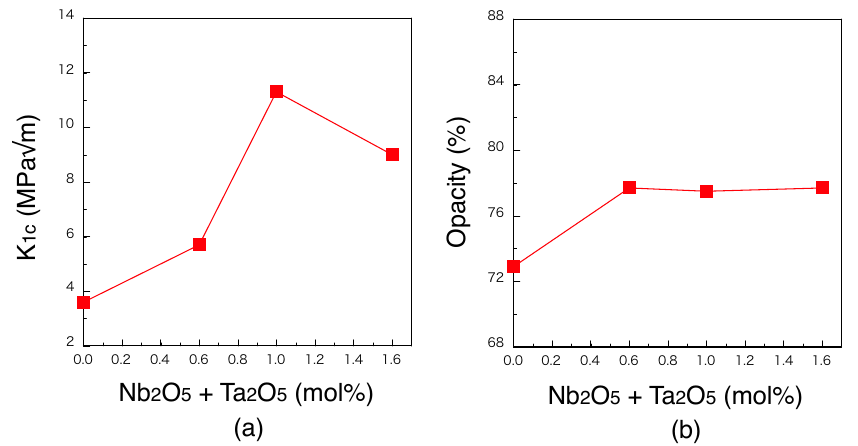
Figure 6. The effect of the total Nb 2 O 5 and Ta 2 O 5 content on ( a ) fracture toughness and ( b ) opacity of ZrO 2 -Y 2 O 3 -Nb 2 O 5 -Ta 2 O 5 (No. 2, 3 and 23–27).